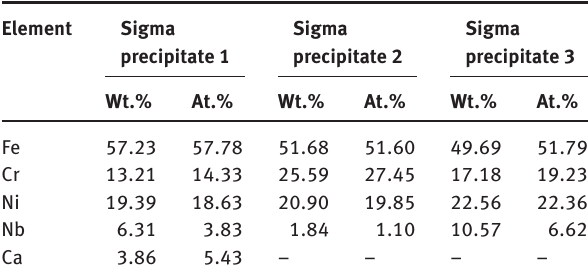
Table 9: SEM-EDAX results of composition for sigma precipitates [34].